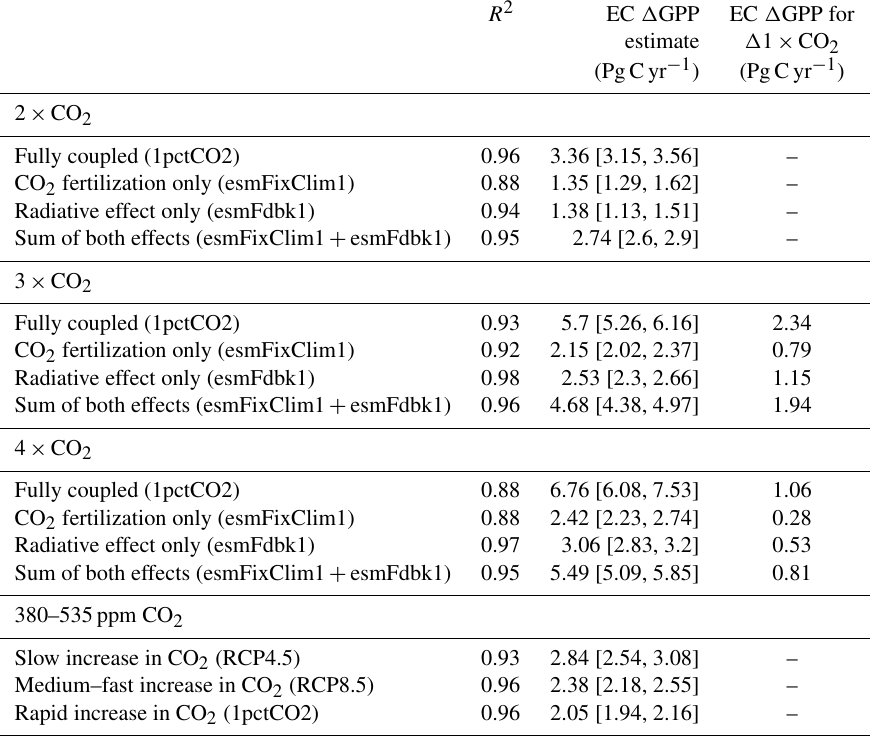
Table 3. Coefficients of determination ( R 2 ) of the emergent linear relationships in Fig. 7 (asterisks denote nonsignificant values: ∗∗ p > 0 . 1; ∗ p > 0 . 05). ECs on (cid:49) GPP (upper and lower bound of uncertainty in square brackets) for different atmospheric CO as well as idealized setups. The rightmost column shows the increase in (cid:49) GPP for an increment of 1 × CO 2 . The lowermost section compares EC estimates of (cid:49) GPP for equivalent changes in CO 2 concentration (CO 2 rises from 380 to 535ppm) but for different time